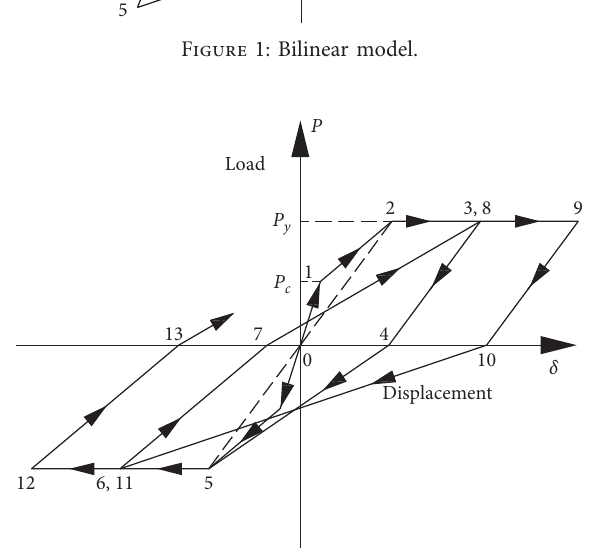
Figure 1: Bilinear model.